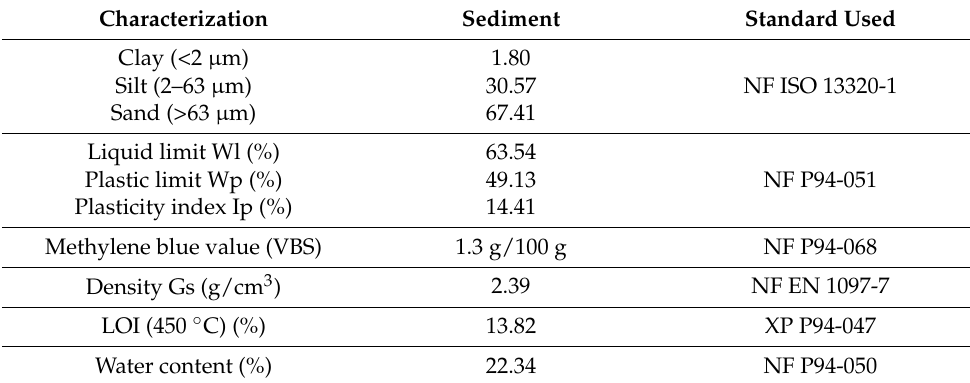
Figure 1. Particle size distribution of sediment Min, Max standard NF XP P13-901 [22]. The physical properties of dredged sediments are presented in Table 1. Table 1. Physical properties of sediment.